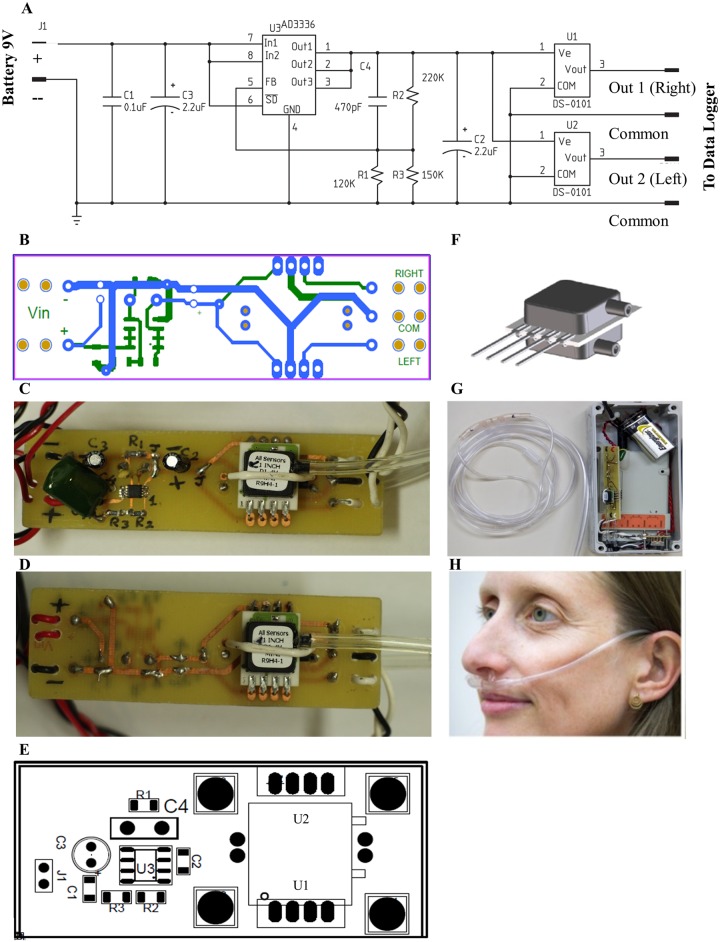
Schematic for nasal cycle logger.(A) Schematic of electronics. (B) Printed circuit board (PCB). Component-side in green, soldering-side in blue. (C) Picture of component-side. (D) Picture of soldering-side. (E) Component layout. (F) Illustration of low Pressure Sensor (1” H2O to 30”H2O). (G) The device in its assembled form. (H) Respiration cannulas positioned in subject’s nares.